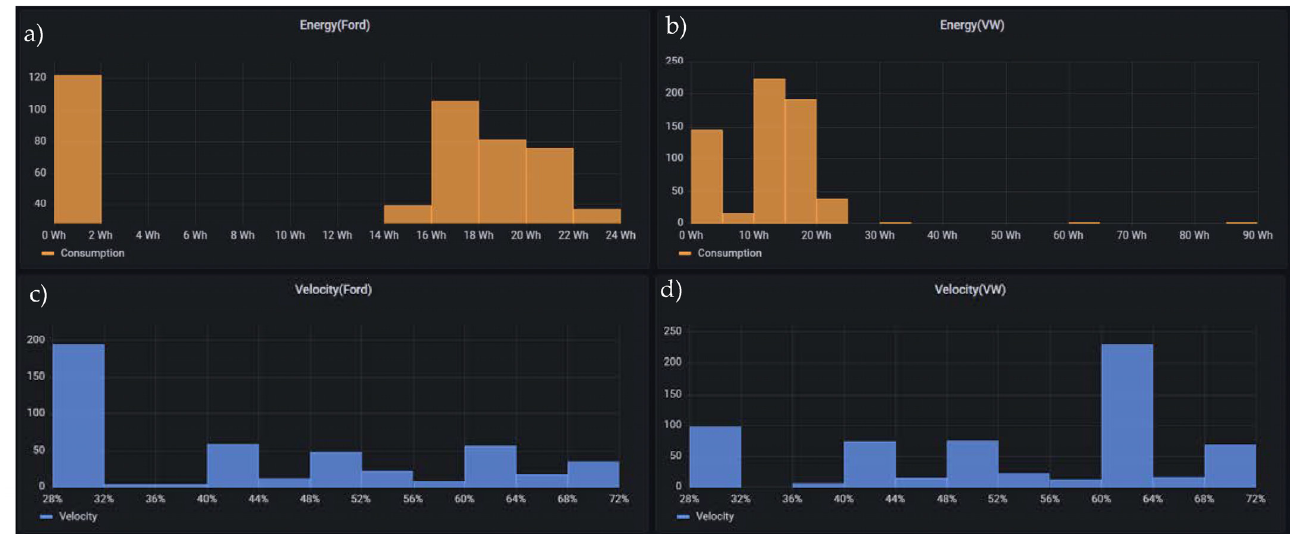
Figure 21. Energy/Velocity histogram panel, the ( a ) and ( b ) the energy consumption for Ford and VW respectively and the ( c ) and ( d ) the percentage velocity for Ford and VW respectively.